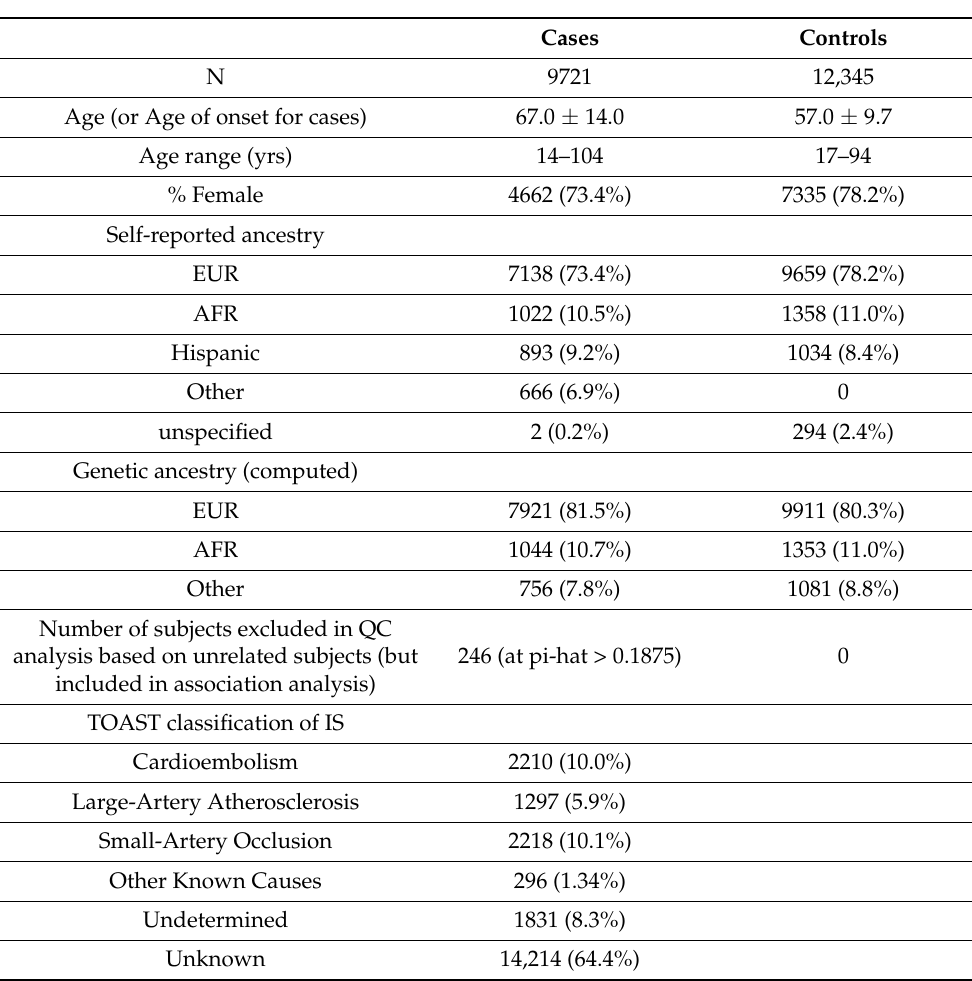
Table 1. Characteristics of study